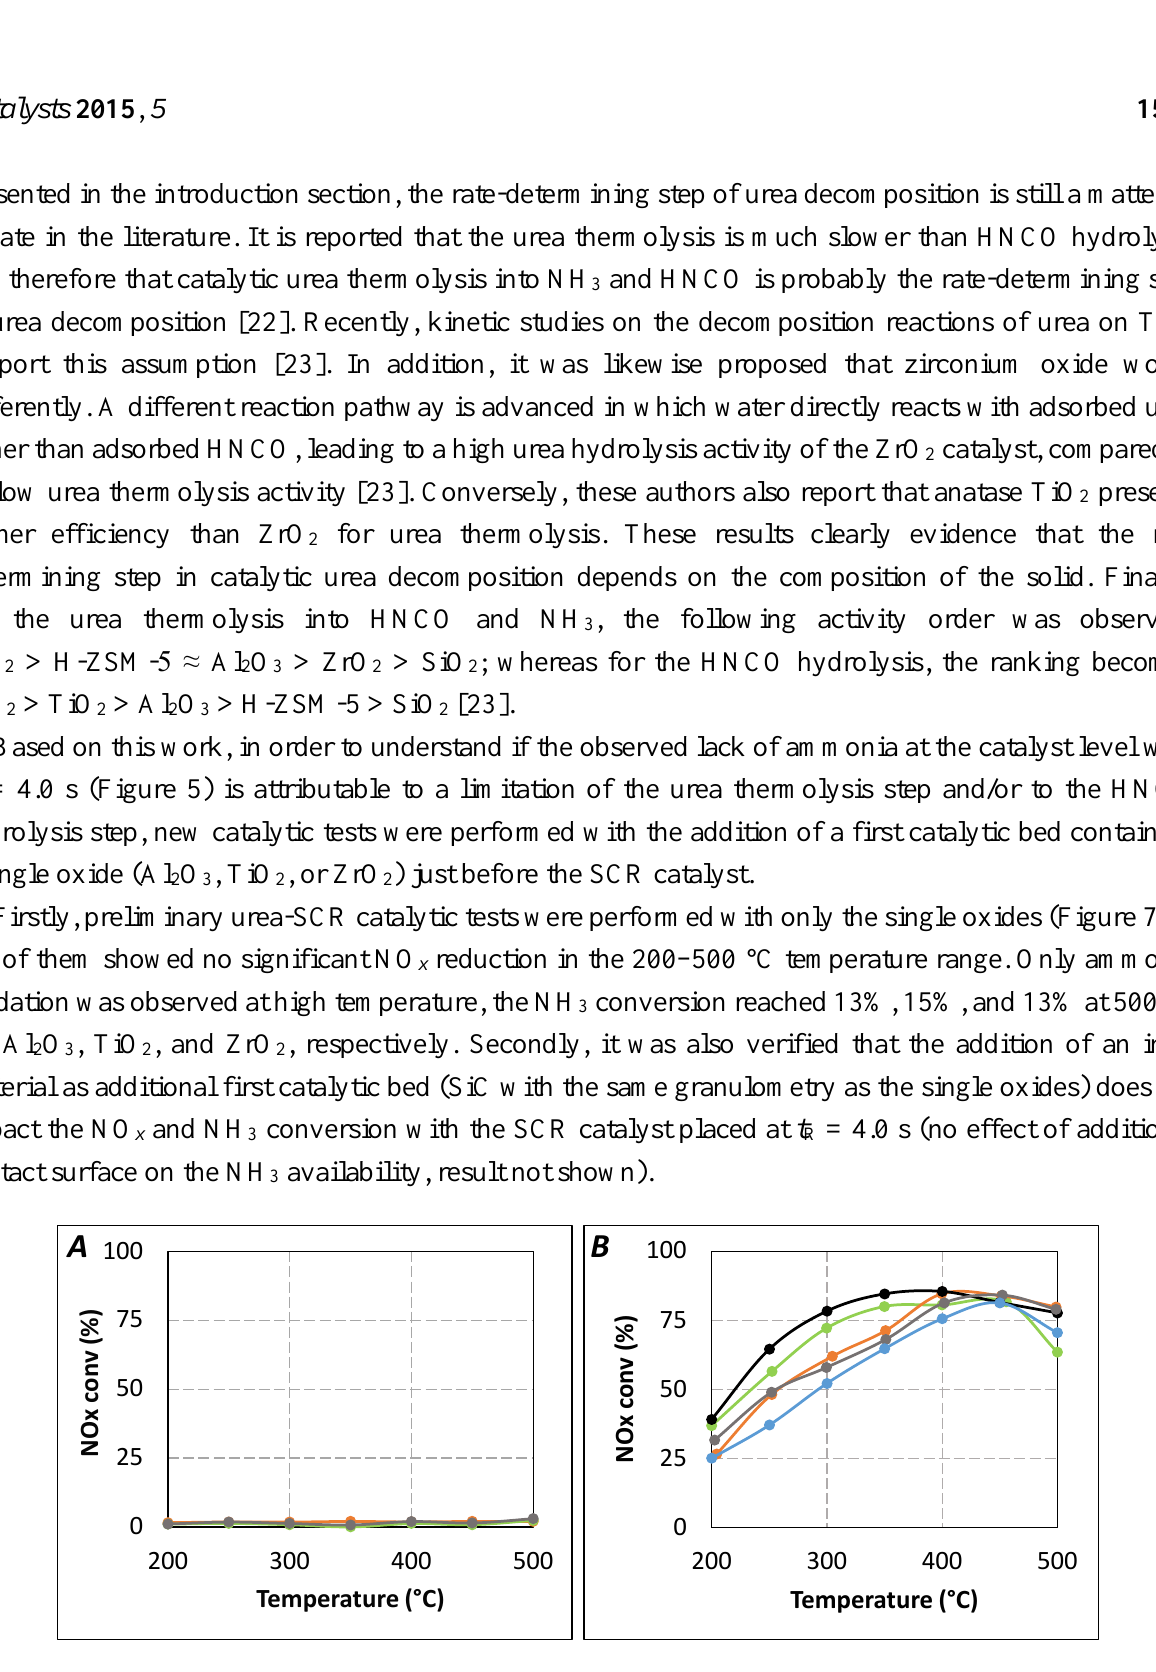
Figure 7. Effect of catalytic double bed in urea-SCR results in standard condition (400 ppm NO, 400 ppm eq. NH 3 , 8% H 2 O, 10% CO 2 , 10% O 2 ). ( A ) Single oxide ( t R = 4.0 s). (▬): ZrO 2(100mg) only; (▬): TiO 2(100mg) only; (▬): Al 2 O 3(100mg) only; ( B ) Double